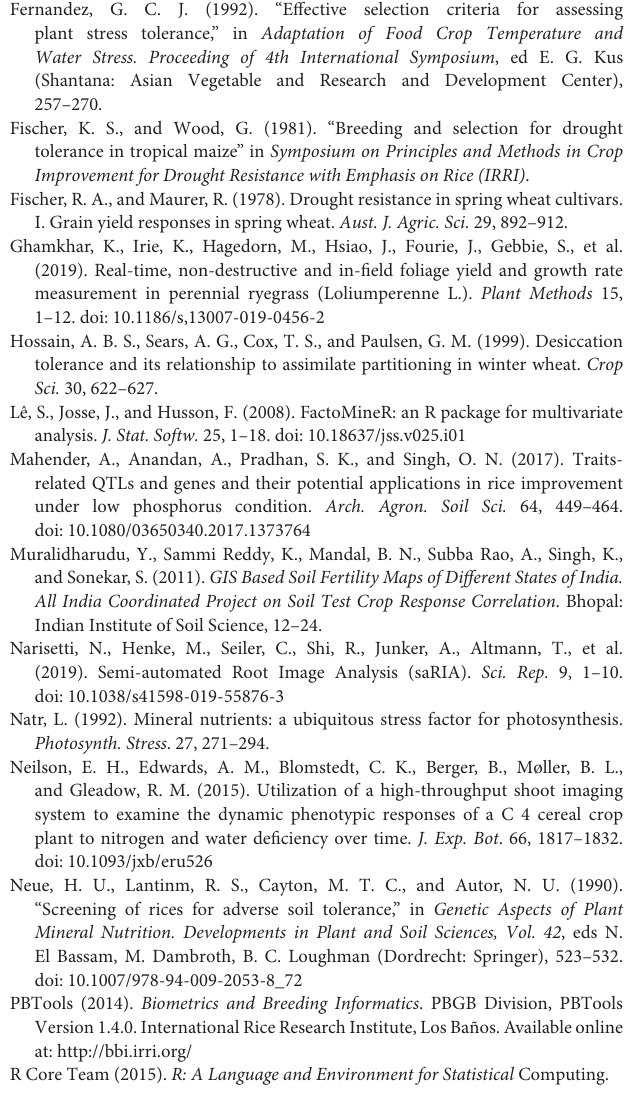
Supplementary Figure 1 | PCA biplot of 68 genotypes based on the variance in eight morpho-physiological traits measured in P stress environment, explained by two axes [PC1 and PC2, selected genotypes (orange) and non-selected genotypes (green)]. Supplementary Figure 2 | Hierarchical clustering of the genotypes based on the level of expression of morpho-physiological traits in low P environment. Supplementary Figure 3 | Hierarchical clustering of the 38 morpho-physiological and geometric traits based on Ward’s method.